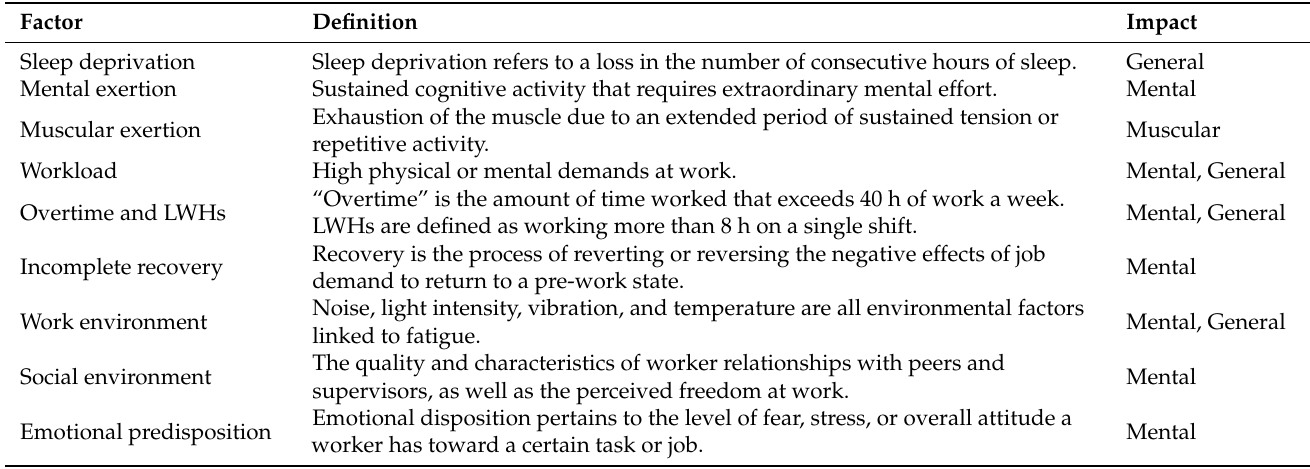
Table 1. General, mental, and muscular contributors to fatigue